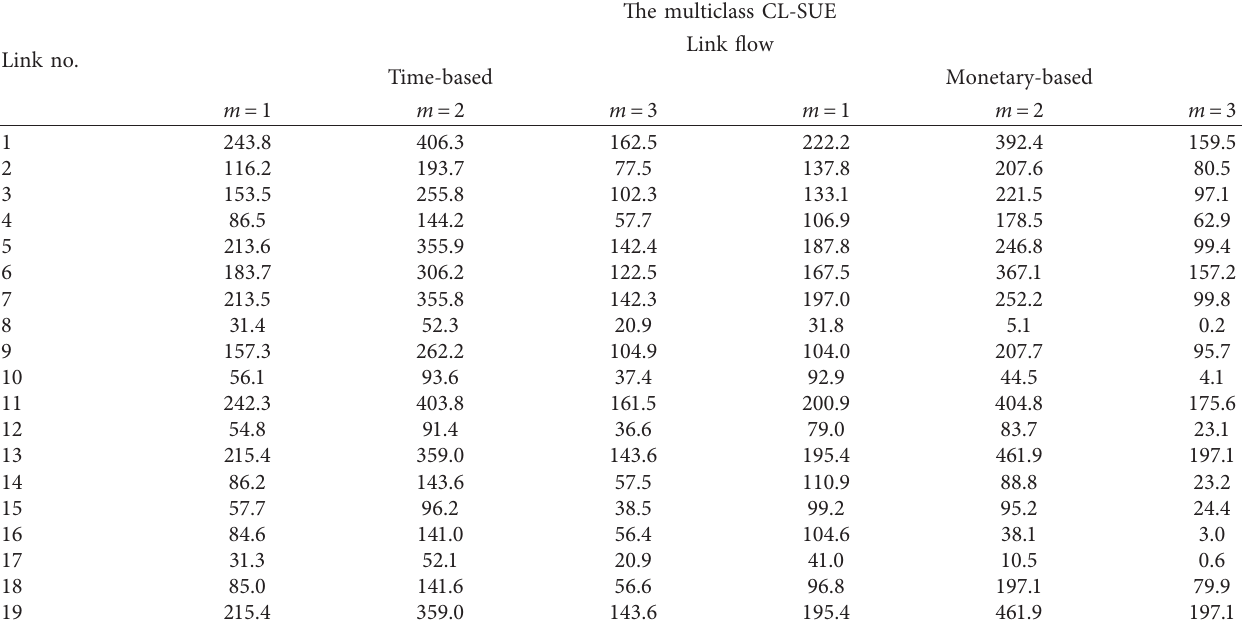
Table 7: Link results of the multiclass CL-SUE